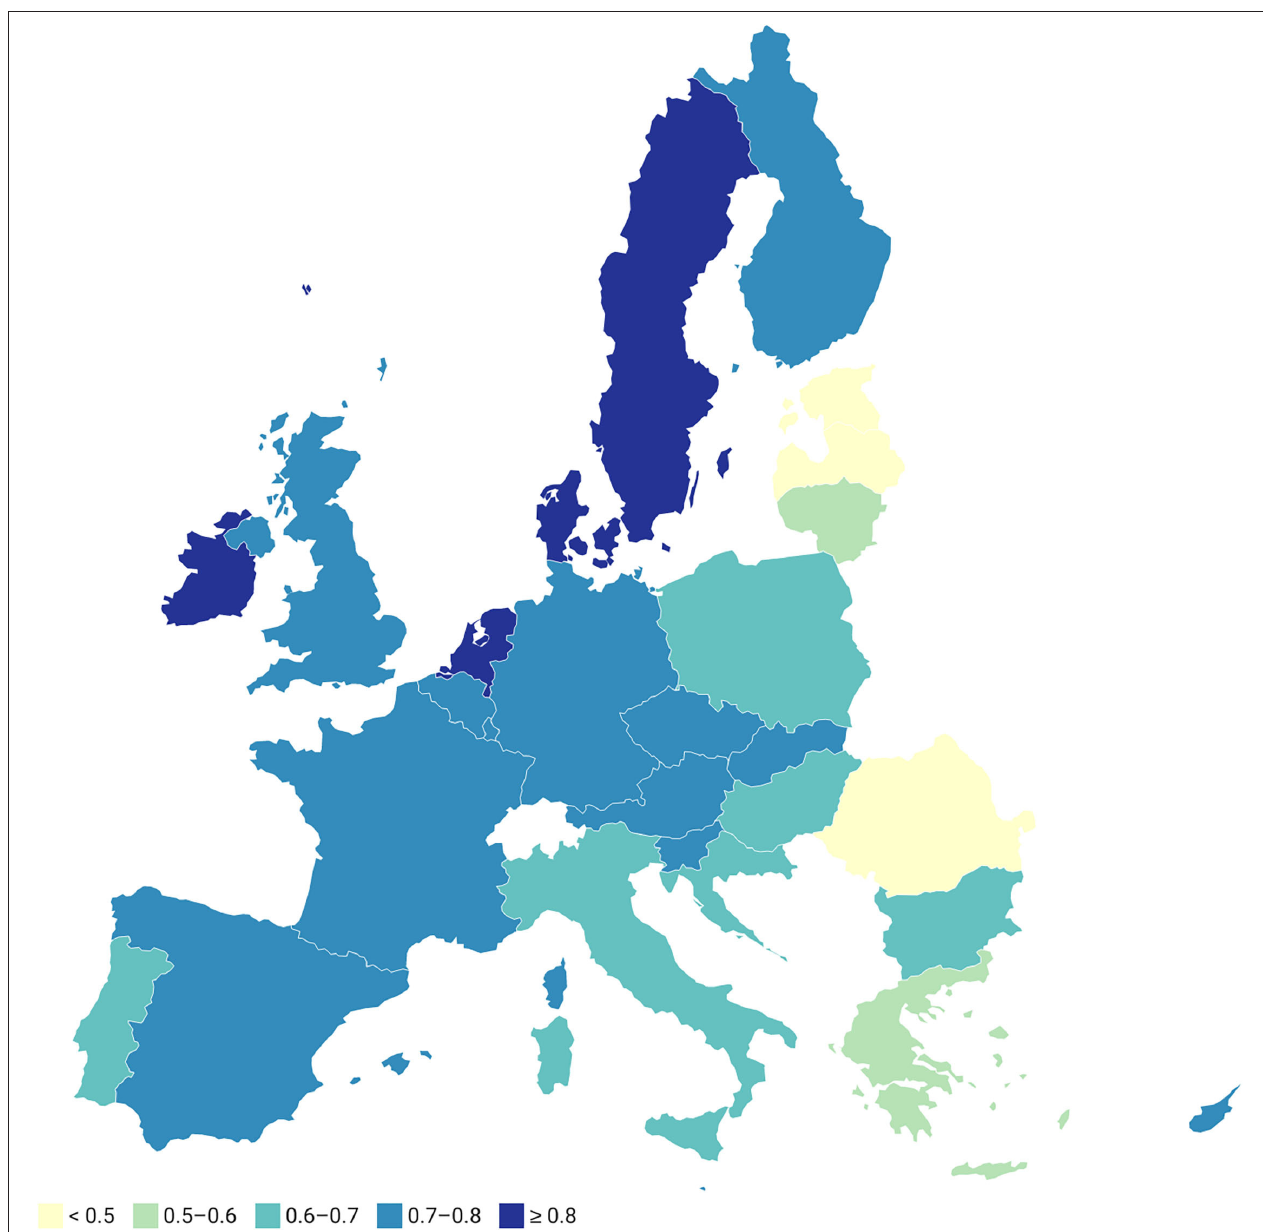
FIGURE 1 | Relative closeness of the EU countries with respect to the ideal solution, 2nd